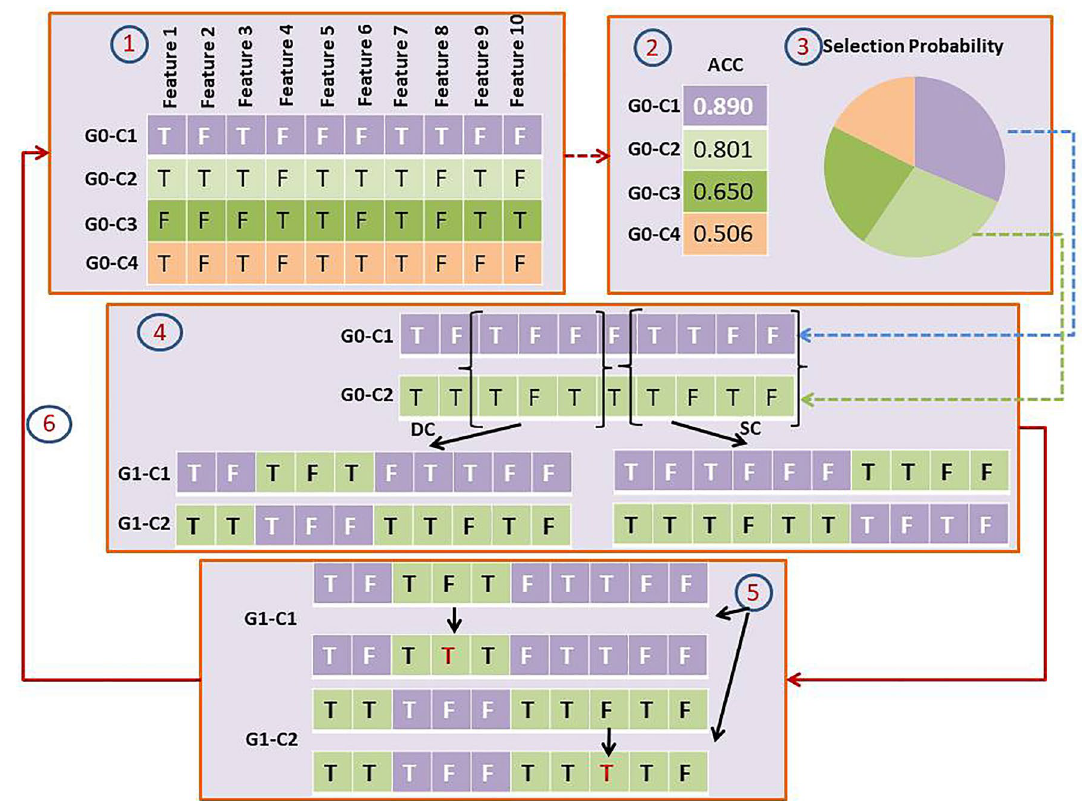
Figure 2. The Genetic Algorithm workflow. The steps are: (1) Generation of the initial population of solutions; (2) Evaluation of fitness values of each solution within the population; (3) The “mating” process of the solution, in which the probability of a solution to be selected is proportional to the estimated fitness value; (4) The random designation of crossover points on each vector of solution during the “mating” process. SC and DC stand for Single- and Double-Crossover, respectively; (5) The introduction of random mutations on the crossover-ed solution vectors; (6) The replacement of the entire population by daughter